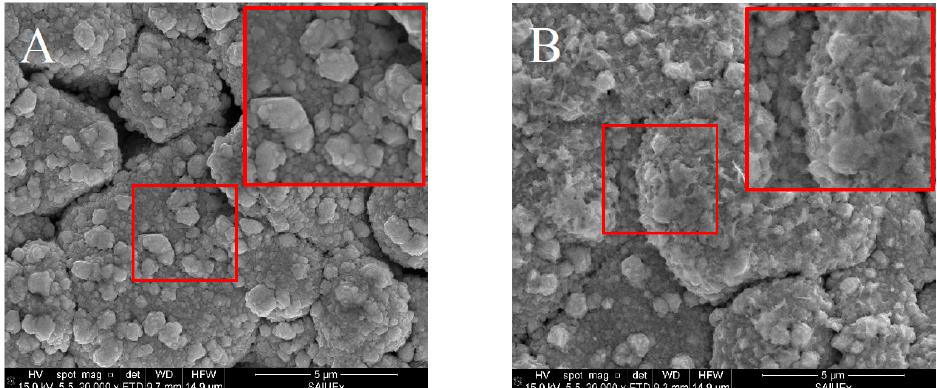
Figure 6. SEM images of commercial Bi SP SPE: ( A ) New electrode. ( B ) Same electrode after 25 voltammetric runs (SWASV as indicated in section 2.5).